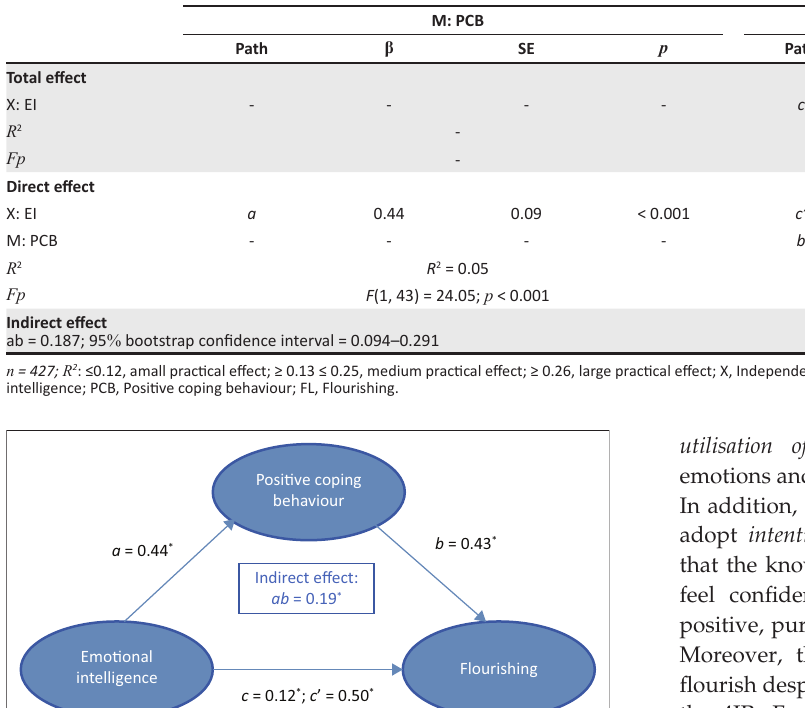
TABLE 5: Mediation analysis results: Positive coping behaviour as mediator. Antecedents